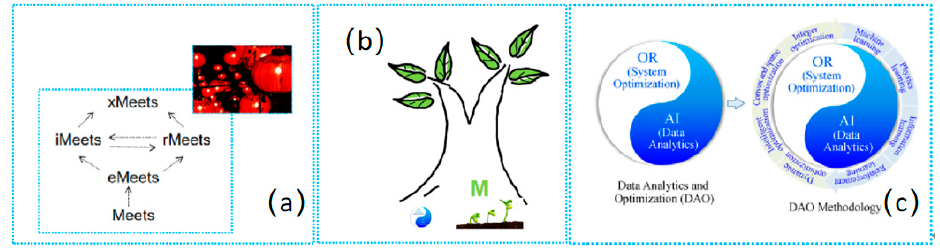
Figure 1. This paper is “iMeets” in the lantern for ETO interpretability [1] or insights. The Chinese lantern ( a ) is derived from a green tree ( b ) of SMO based scheduling. The tree is named as “knowledge driven scheduling”, which is short for “Big K Tree”. The “Big K Tree” is rooted in “tai ji” [2] of DAO ( c